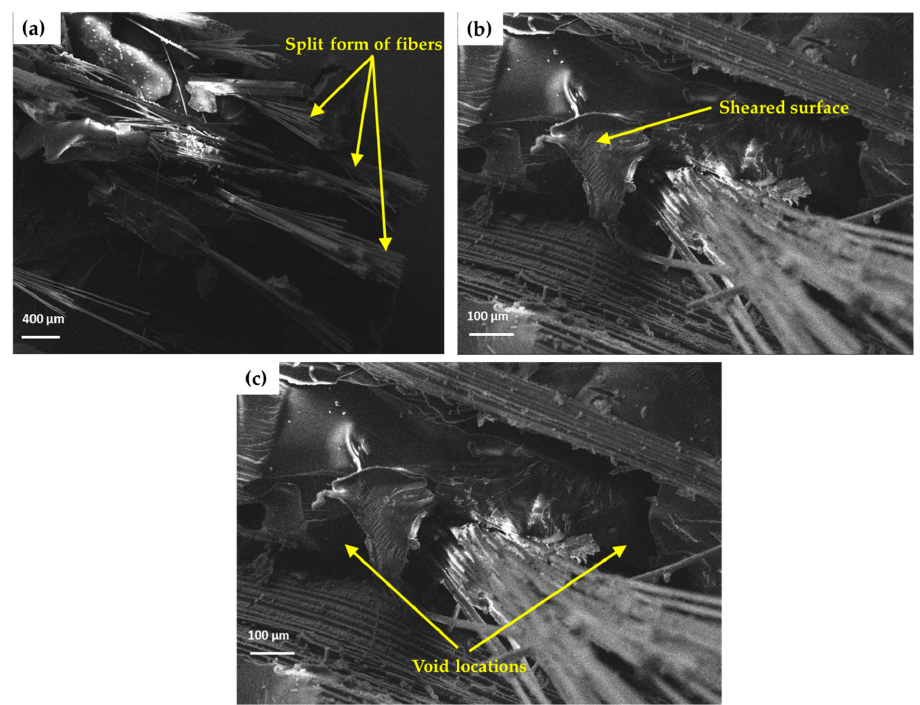
Figure 7. SEM photographs of ( a ) surface of the composite after tensile test, ( b ) sheared surface after wear test, and ( c ) void location in the composite among fibres.